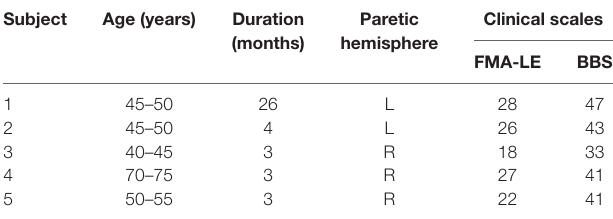
Table 1 | Background data of the stroke survivors.